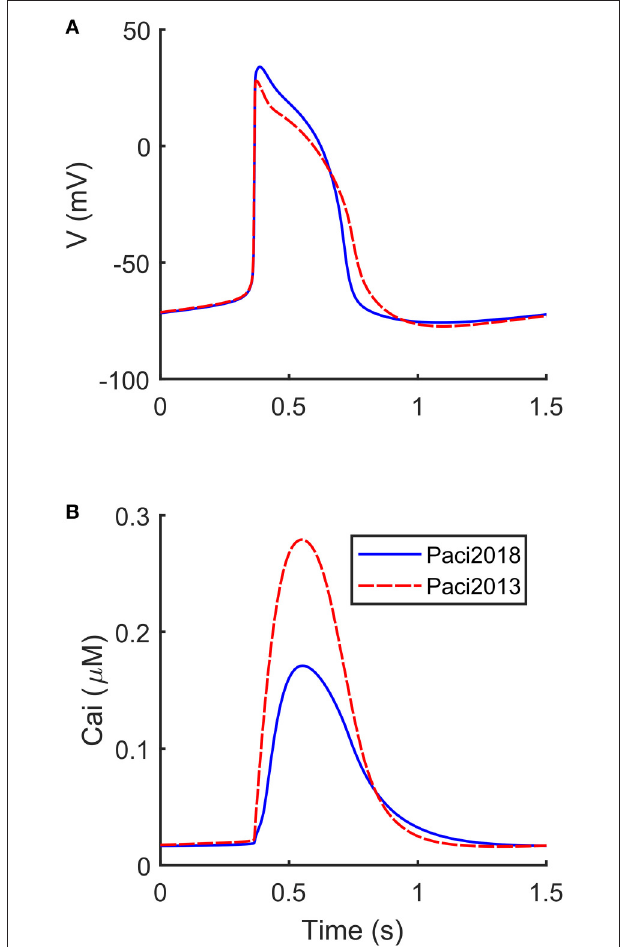
FIGURE 1 | Comparison between the APs and Ca 2 + transients simulated by the new Paci2018 model (solid blue) and the Paci2013 model (dashed red). (A) membrane potential. (B) Ca 2 +